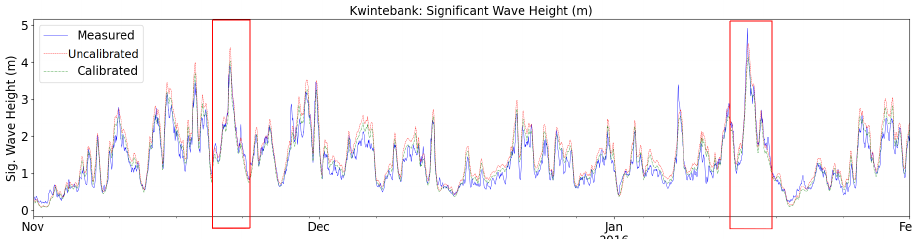
Figure 8. Significant wave height peaks of two storms chosen for spectral analysis at Kwintebank (forced with the DOWA wind). The storm peaks considered are at 21 November 2015 16:00 and 15 January 2016